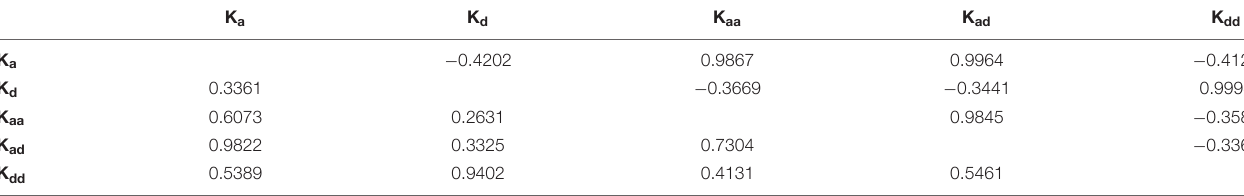
TABLE 2 | Correlations between different genomic relationship